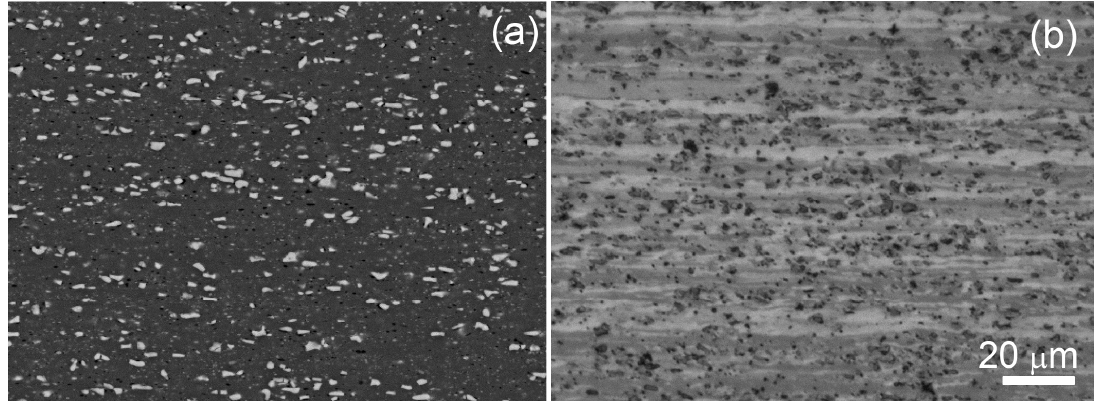
Figure 1. Initial microstructure after ( a ) cold rolling, SEM; ( b ) LM-image after annealing at a temperature of 520 ° С for 30 min.